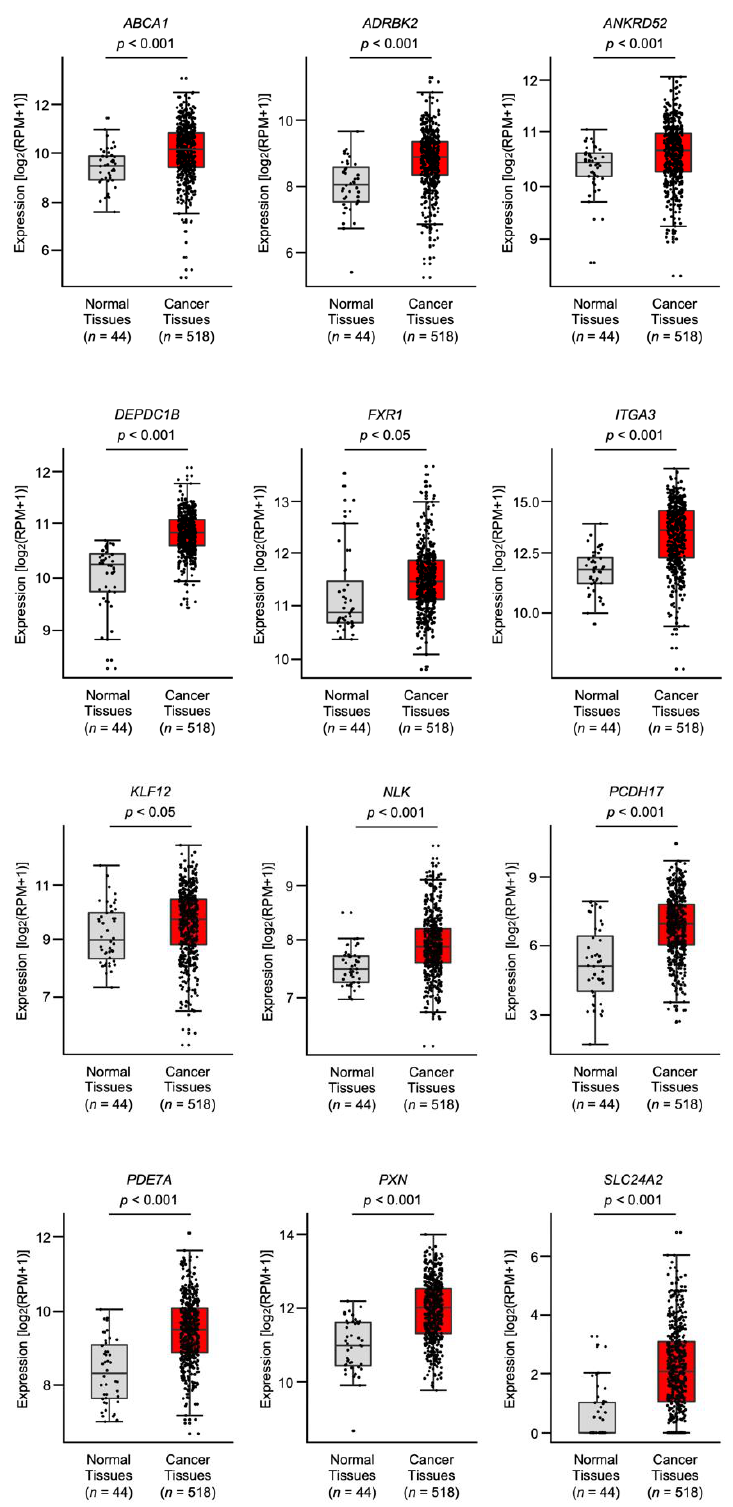
Figure 2. HNSCC tissue expression of 12 target genes with miR-199-5p- and miR-199-3p -binding sites in their 3’UTRs using TCGA-HNSC data. The expression levels of 12 genes ( ABCA1 , ADRBK2 , ANKRD52 , DEPDC1B , FXR1 , ITGA3 , KLF12 , NLK , PCDH17 , PDE7A , PXN , and SLC24A2 ) were analyzed using TCGA-HNSC database. A total of 518 HNSCC tissues and 44 normal epithelial tissues were